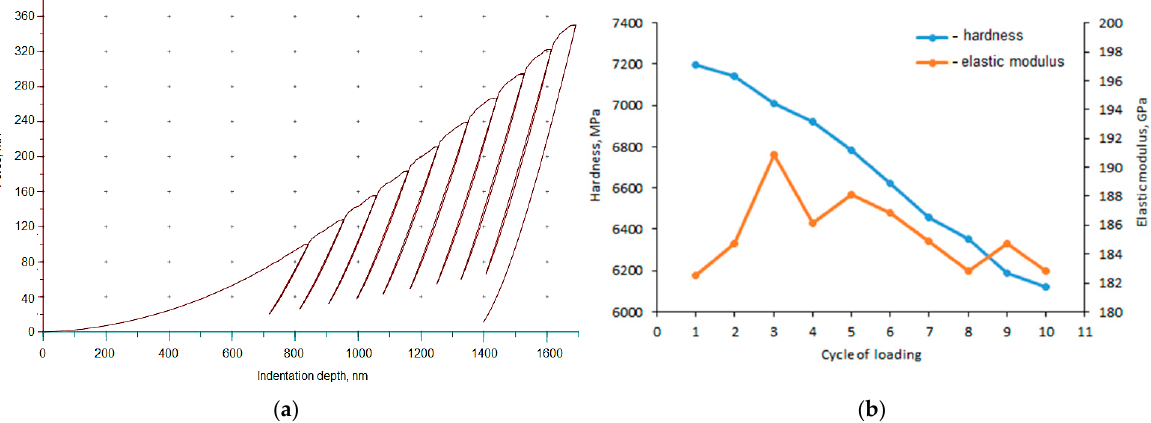
Figure 3. Force versus indentation depth curves for a Ni–P coating: ( a ) hardness and elastic modulus change with loading cycle ( b ).